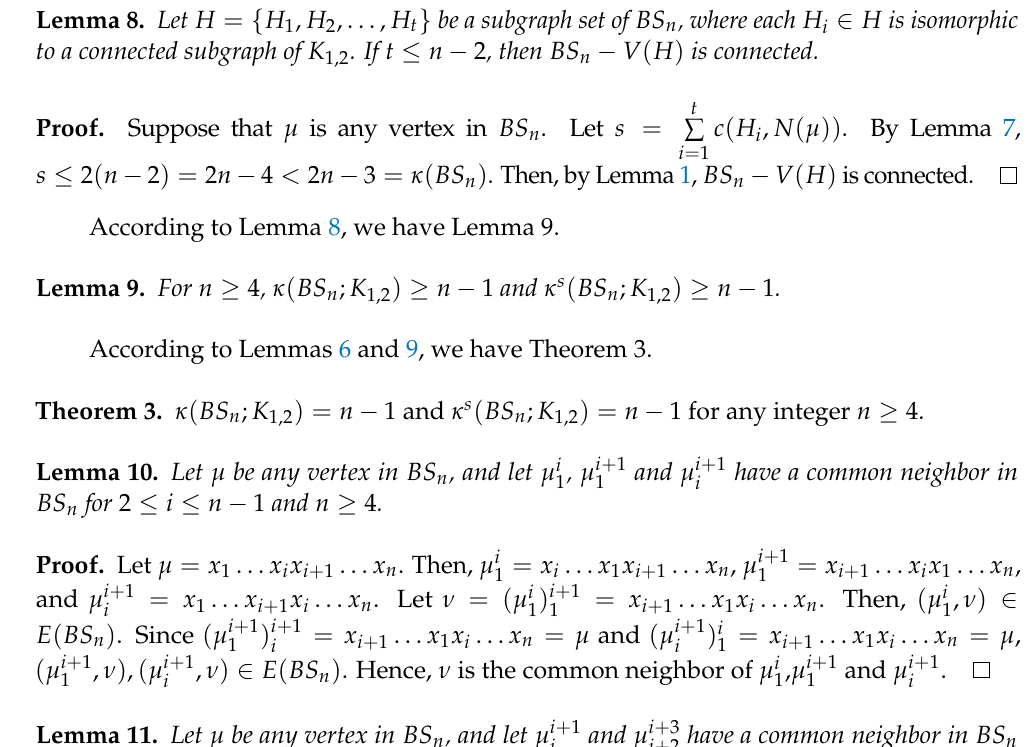
Figure 3. An example of κ ( BS n ; K 1,2 ) ≤ n − 1 and κ s ( BS n ; K 1,2 ) ≤ n − 1 where n =